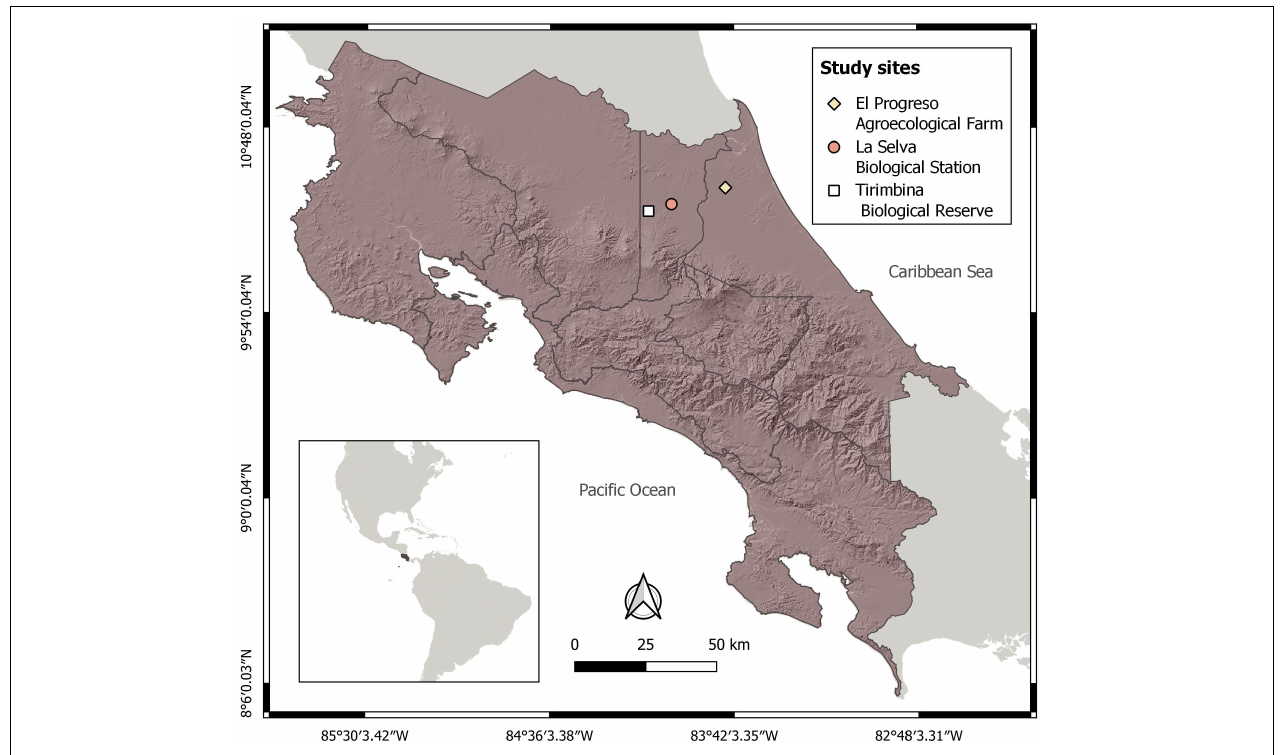
FIGURE 1 | Location of study sites in the lowland rainforests of the NE Caribbean slope of Costa